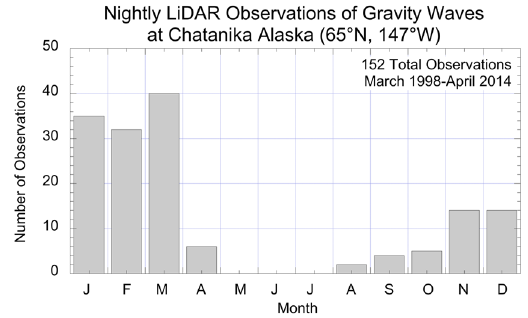
Figure 1. Histogram by month of Rayleigh LiDAR observations at Chatanika, Alaska, between March 1998 and April 2014.